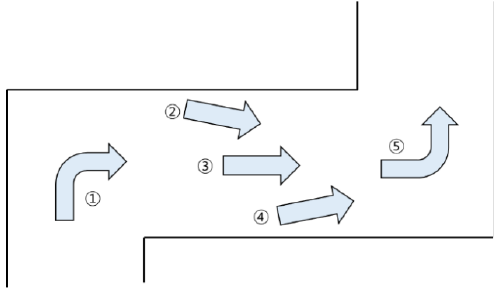
Figure 4. Autonomous Driving Commands.